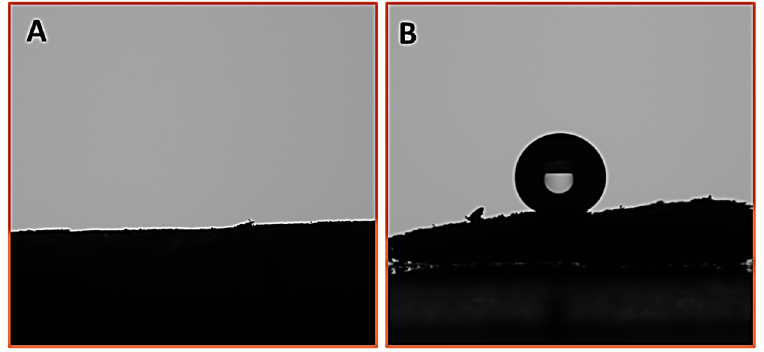
Figure 5. Water contact angle on the surface of ( A ) Cell-F and ( B ) C18s-Ag-DA-Cell-F, measured after 15 s by placing 5 µL drop of water. 15 s by placing 5 µ L drop of